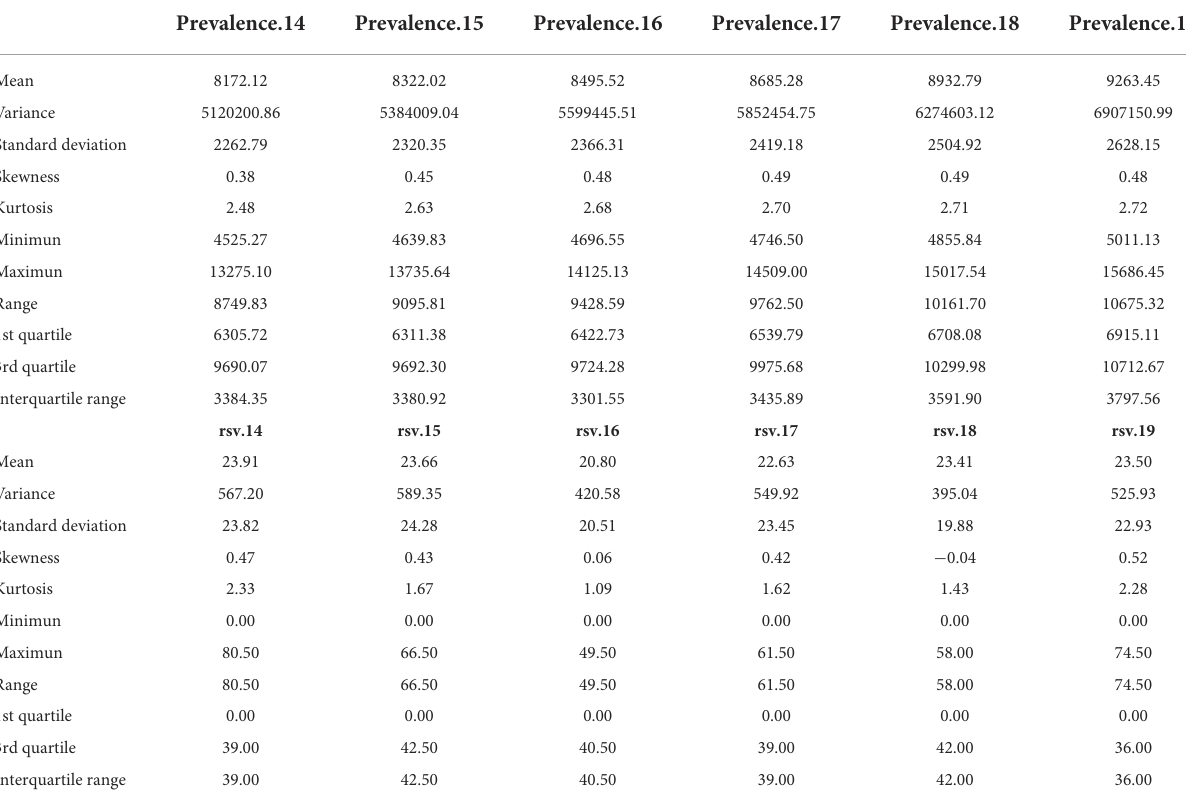
TABLE 1 Descriptive statistics for diabetes mellitus prevalence and relative search volumes from 2014–2019 for European countries.